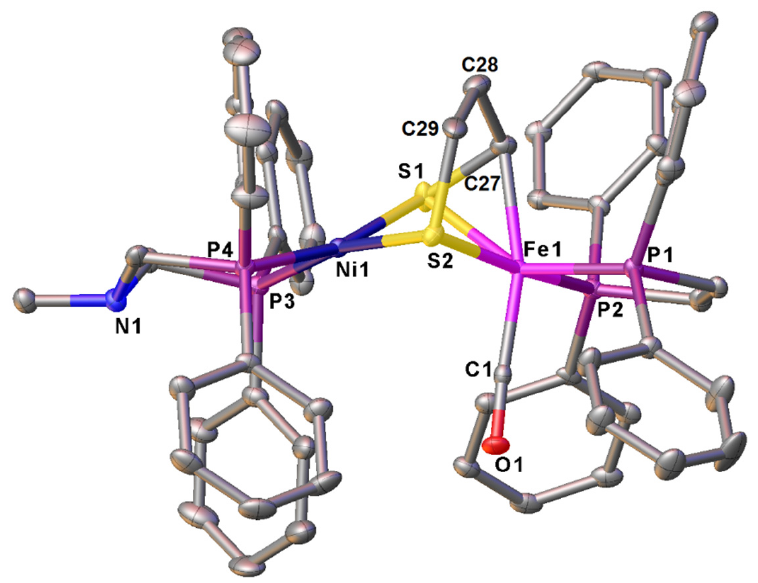
Figure 5. Molecular structure of [ 4 ]BF 4 with thermal ellipsoids drawn at a 30% probability level. All H atoms and one BF 4 − anion are omitted for the sake of clarity. Selected bond lengths (Å) and angles ( ° ): Ni ⋅⋅⋅⋅ Fe 2.9751, Ni1-S1 2.1805(14), Ni1-S2 2.2103(14), Fe1-S1 2.3330(14), Fe1-S2 2.2755(14), Fe1-P1